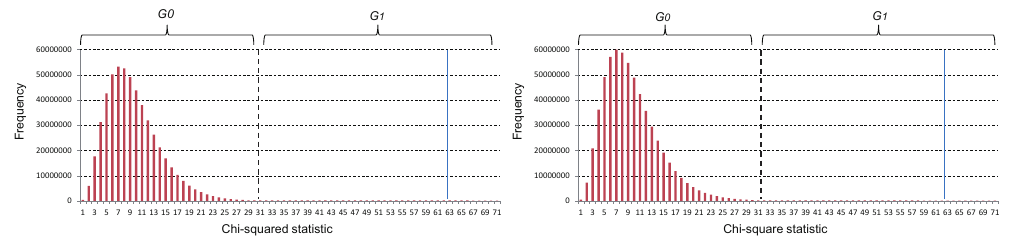
Figure 3. Distributions of chi-square statistics of all pairwise SNPs. The left and right histogram are the distribution of SNP combinations in Chromosomes 1 and 2 on the WTCCC CD data, respectively. Each bar indicates the number of pairwise combinations with the chi-square statistics in a continuous interval (1 in length), except the last bar, for which the interval is infinity. The blue solid line indicates the chi-squared statistic corresponding to a Bonferroni-corrected significance threshold. A combination whose chi-squared statistics is on the right of the blue solid line indicates that it has significant association with